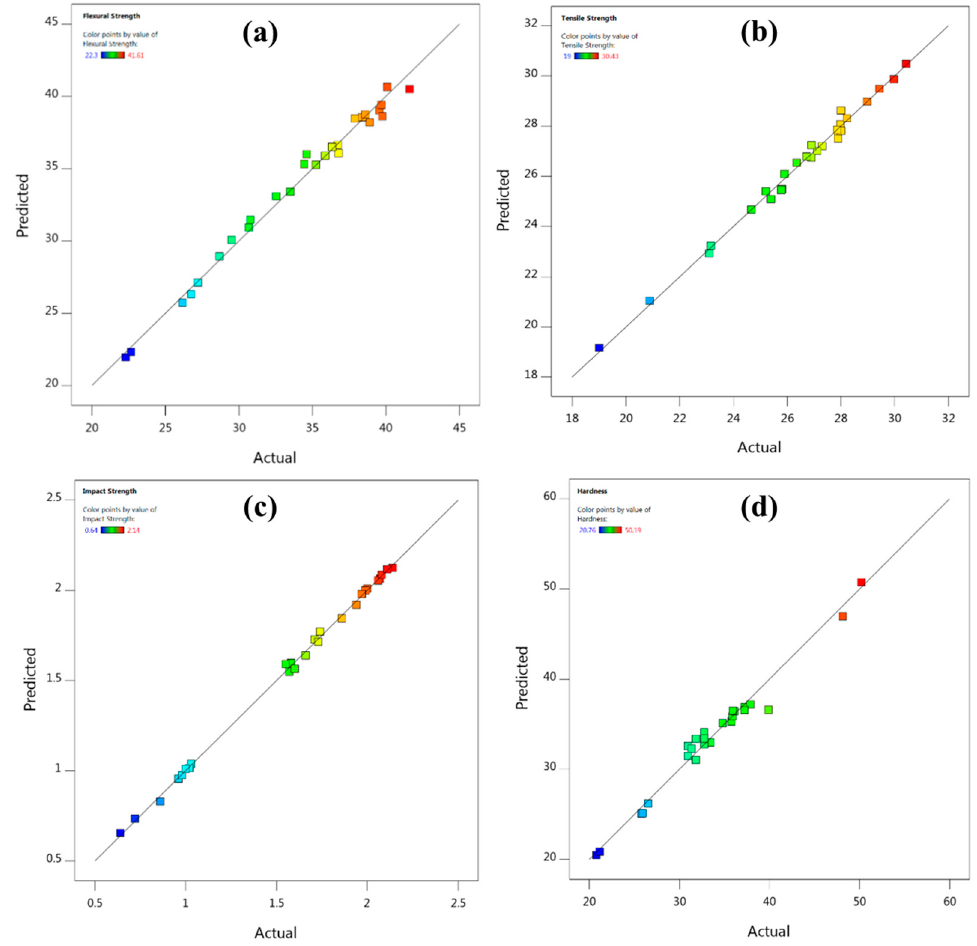
Figure 5. Actual vs. predicted values for ( a ) flexural strength ( b ) tensile strength, ( c ) impact strength and ( e ) hardness.